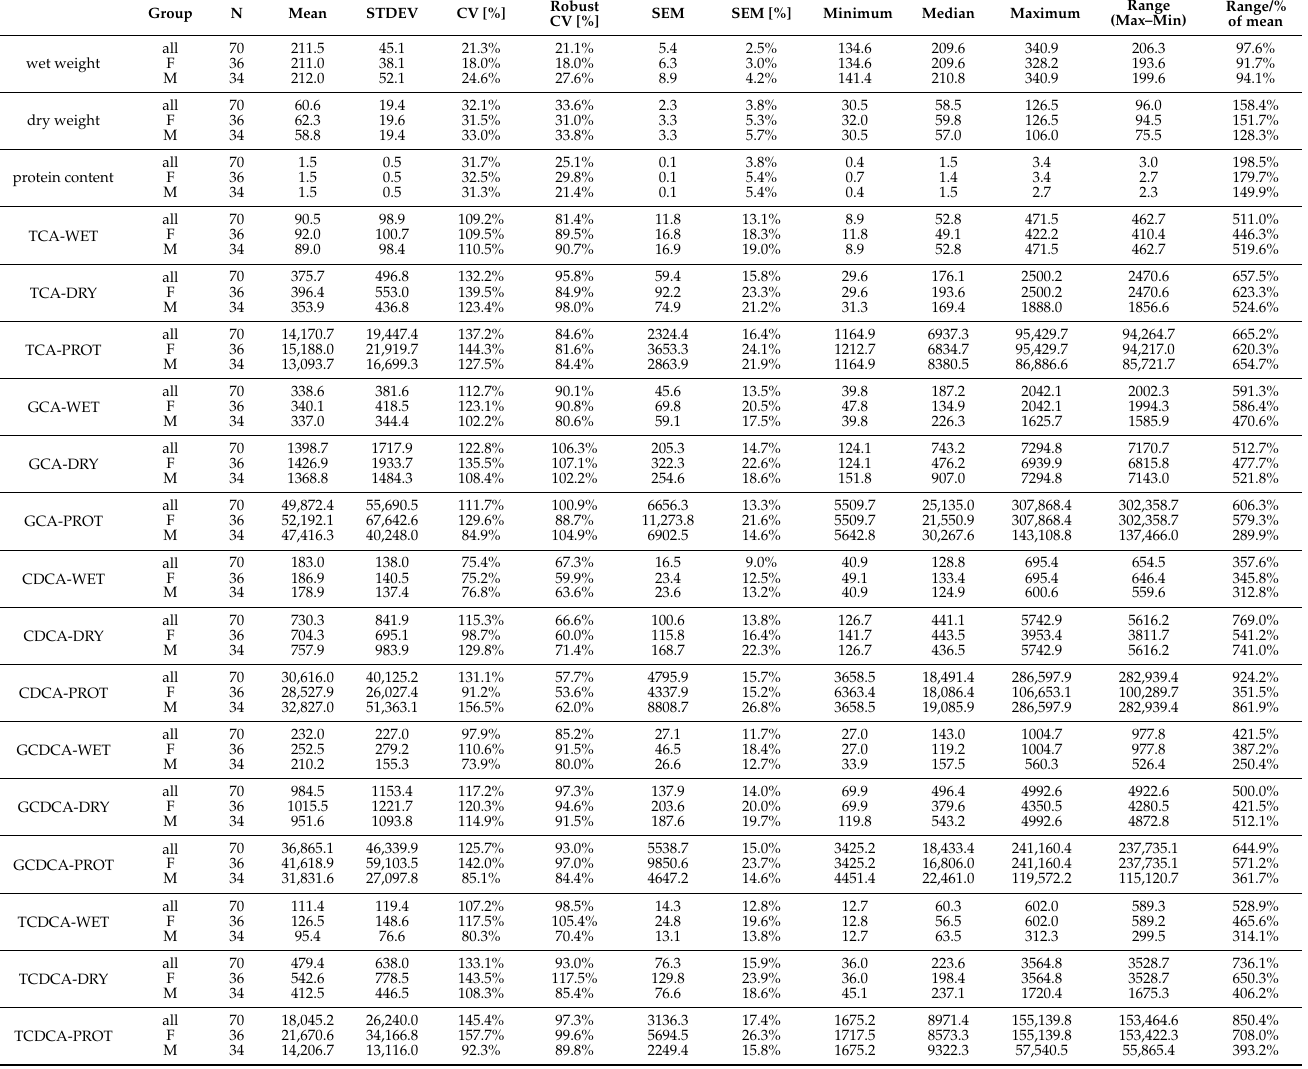
Table 1. The statistical analysis of the wet, dry weight and protein content of the 70 samples from 42 healthy volunteers as well as the measured concentrations of the five bile acids TCA, GCA, CDCA, GCDCA, and TCDCA. Shown are mean (pmol/g), standard deviation (pmol/g), coefficient of variation (in percentage %), robust coefficient of variation (in percentage %), standard error of the mean (pmol/g), standard error of the mean (in percentage %), minimum (pmol/g), median (pmol/g), maximum (pmol/g), range (pmol/g), range in percent of the